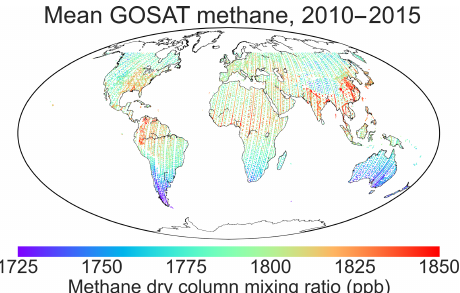
Figure 1. 2010–2015 average of the GOSAT methane dry column mixing ratios used in our inversion. Data are from the University of Leicester version 7 CO 2 proxy retrieval (Parker et al., 2015), ex- cluding glint observations over the oceans and observations pole- ward of 60 ◦ . GOSAT pixels are of 10km circular diameter and are inflated here to 0.5 ◦ for visibility. The red stripes are an averaging artifact as these retrievals are from towards the end of the 2010– 2015 time period when methane was higher.